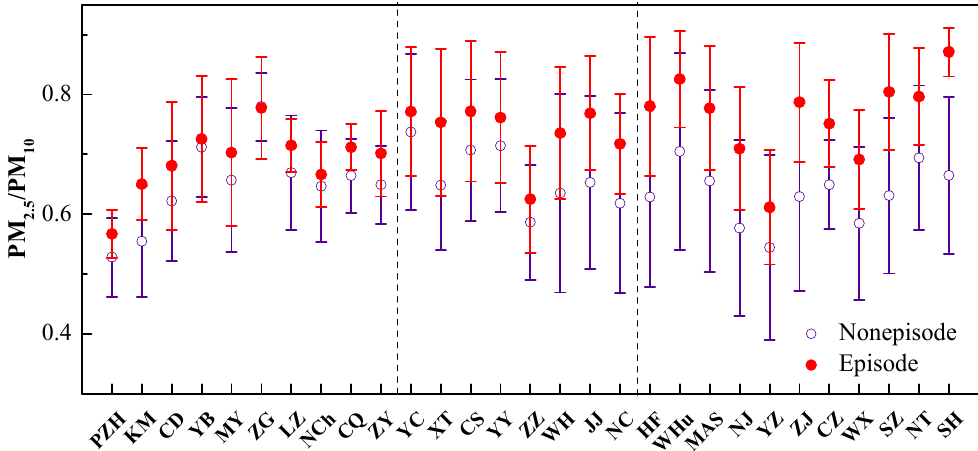
Figure 4. Mean PM 2.5 /PM 10 ratios and standard deviations in the Episode and Nonepisode days.